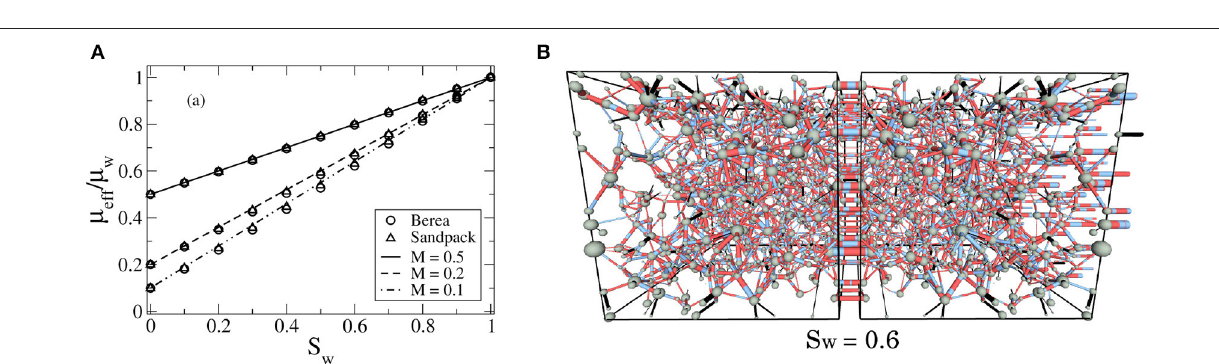
lubrication layers flow comes close to the parallel-coupling scenario, which is described by α 1, but there is still = − a significant difference. The flow paths that appear in parallel 0.5 behavior = − are not stationary as they would be in a parallel